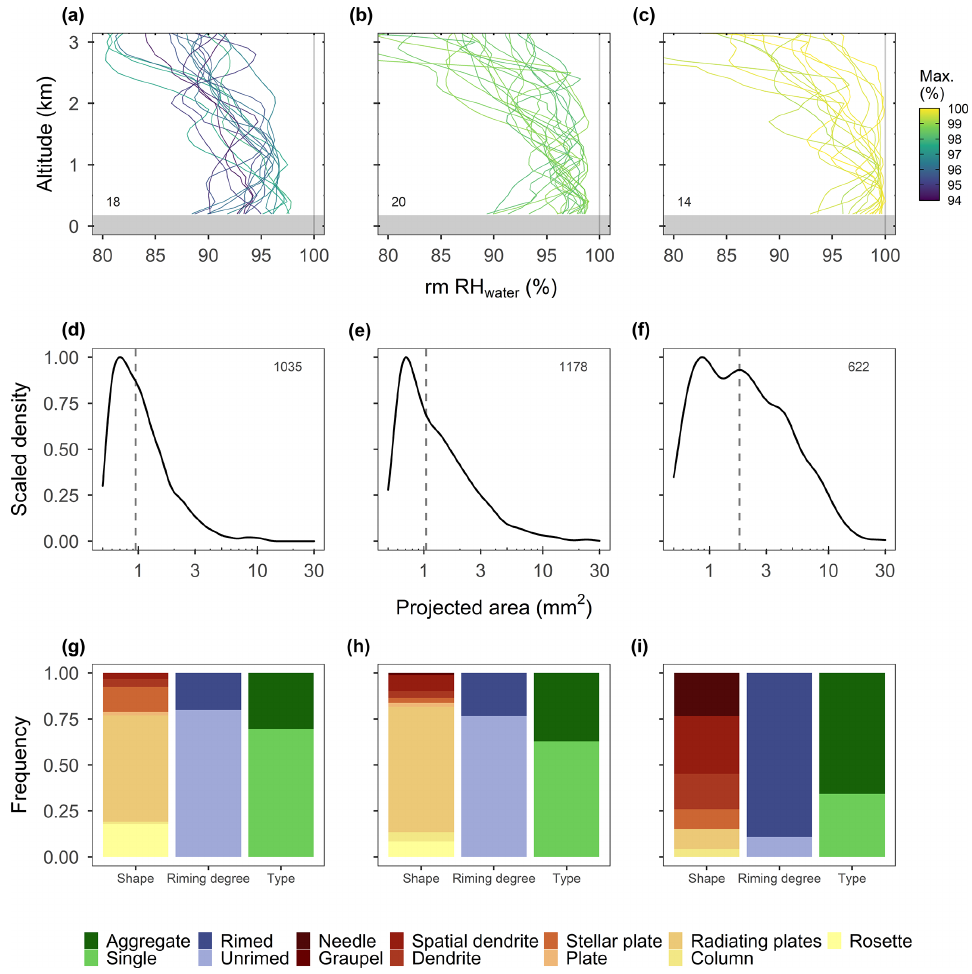
Figure 9. (a, b, c) Running mean RH water profiles coinciding with snowfall and running mean RH ice ≥ 97% throughout the lower 2.7km (52 events) grouped by the maximum running mean RH water . The maximum running mean RH water along the altitude profile is shown in colour. (a) Profiles with a maximum running mean RH water < 98%. (b) Profiles with a maximum running mean RH water ≥ 98% and < 99%. (c) Profiles with a maximum running mean RH water ≥ 99%. For each panel, the number of profiles is indicated in the left bottom corner. (d, e, f) The scaled density of ice particles by projected area (mm 2 ). All the analysed ice particles of the profiles in the above-lying panel were considered. The dashed vertical line indicates the median area. The number of analysed ice particles is indicated by the number provided in the upper right corner. During the 52 snowfall events, a total of 2835 ice particles were analysed. (g, h, i) Same as Fig. 8, but considering only the specifiable ice particles coinciding with the events of the above-lying